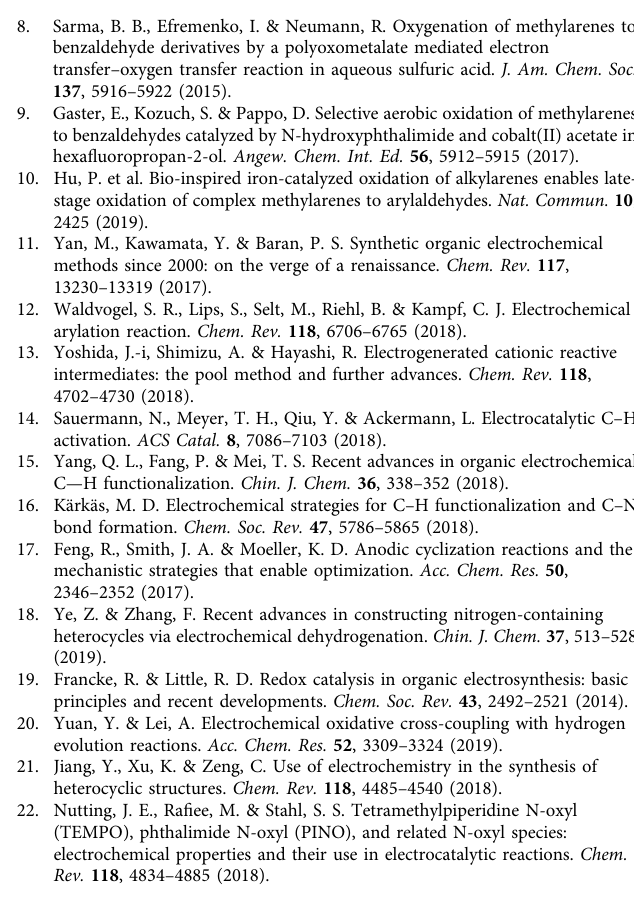
Fig. 6 Investigation on the site-selectivity of the electrooxidation of methylarenes. a Radical bromination of 81 with NBS. b Computed LUMOs and NPA charges of radical cations derived from various methylated benzoheterocycles. N, C, O, S, and H atoms are colored in blue, gray, red, yellow and white, respectively. The LUMOs are visualized by light blue and yellow isosurfaces. The NPA charges of the atoms bearing a Me group are indicated by black (C6) and blue numbers. NBS N-bromosuccinimide, AIBN